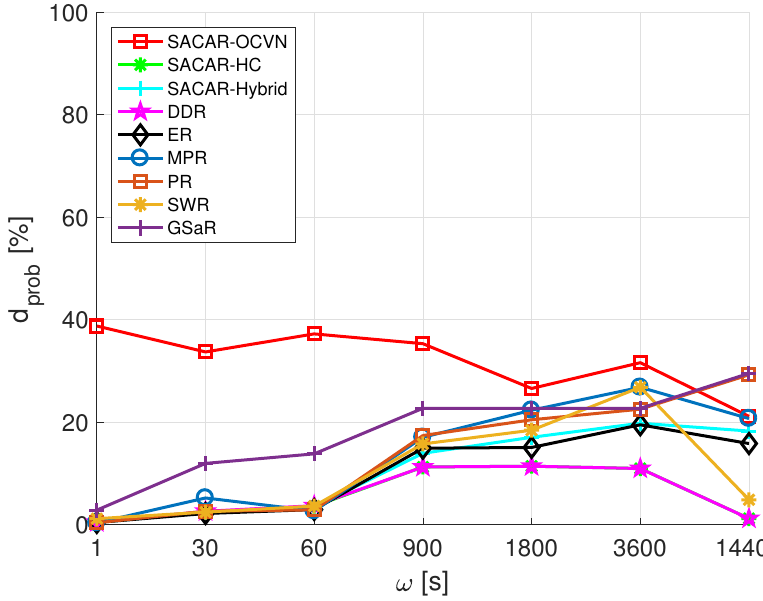
Figure 12. Average delivery probability ( d prob ) vs. frequency of message generation ( ω ):